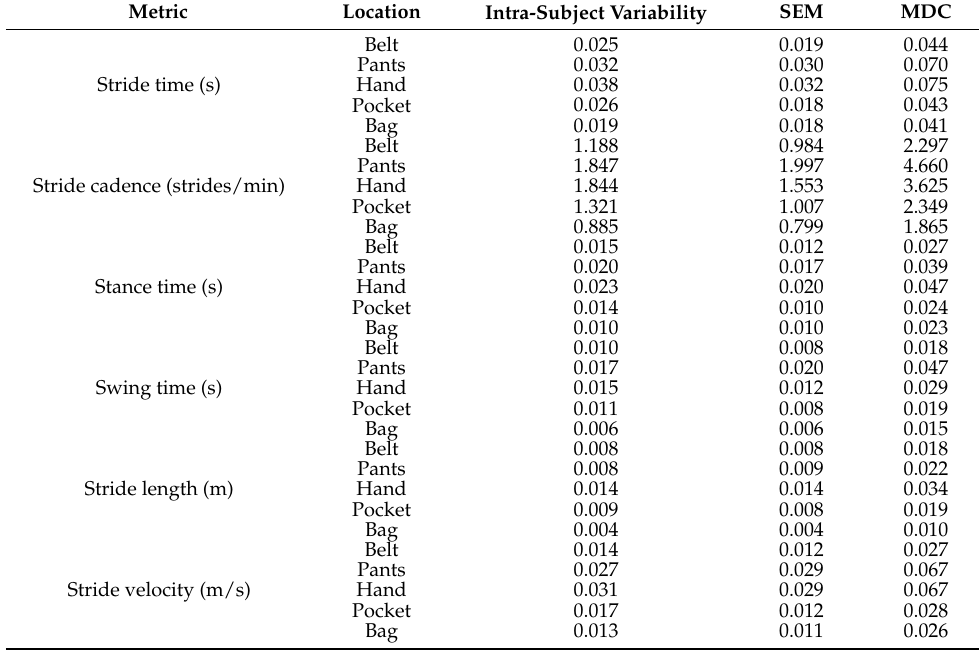
Figure 2. The differences between SEM and the intra-subject variability for each metric and smart- phone location. Table 4. Intra-subject variability, SEM and MDC for each metric and smartphone